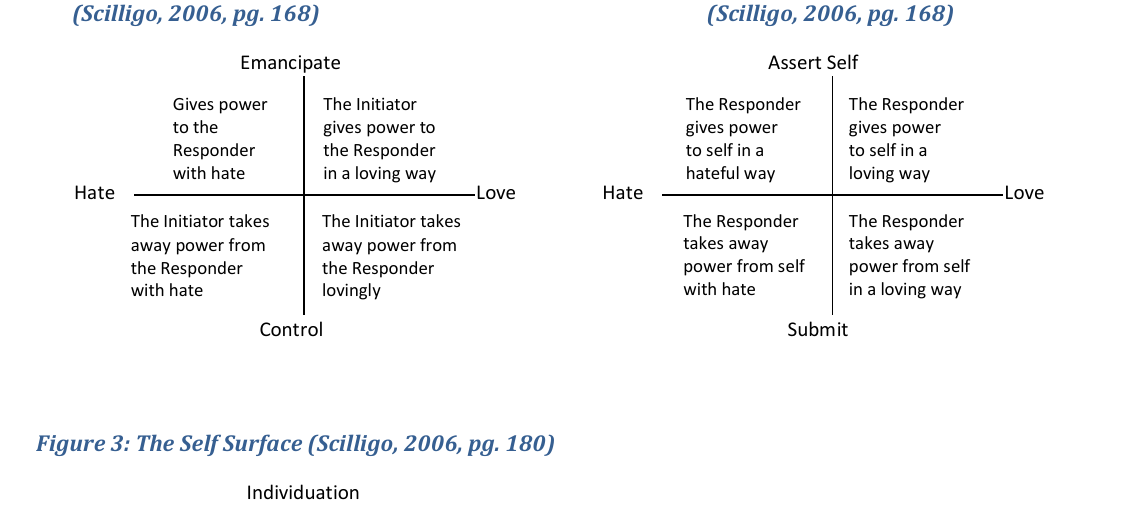
Figure 1: The Initiator Surface Figure 2: The Responder Surface